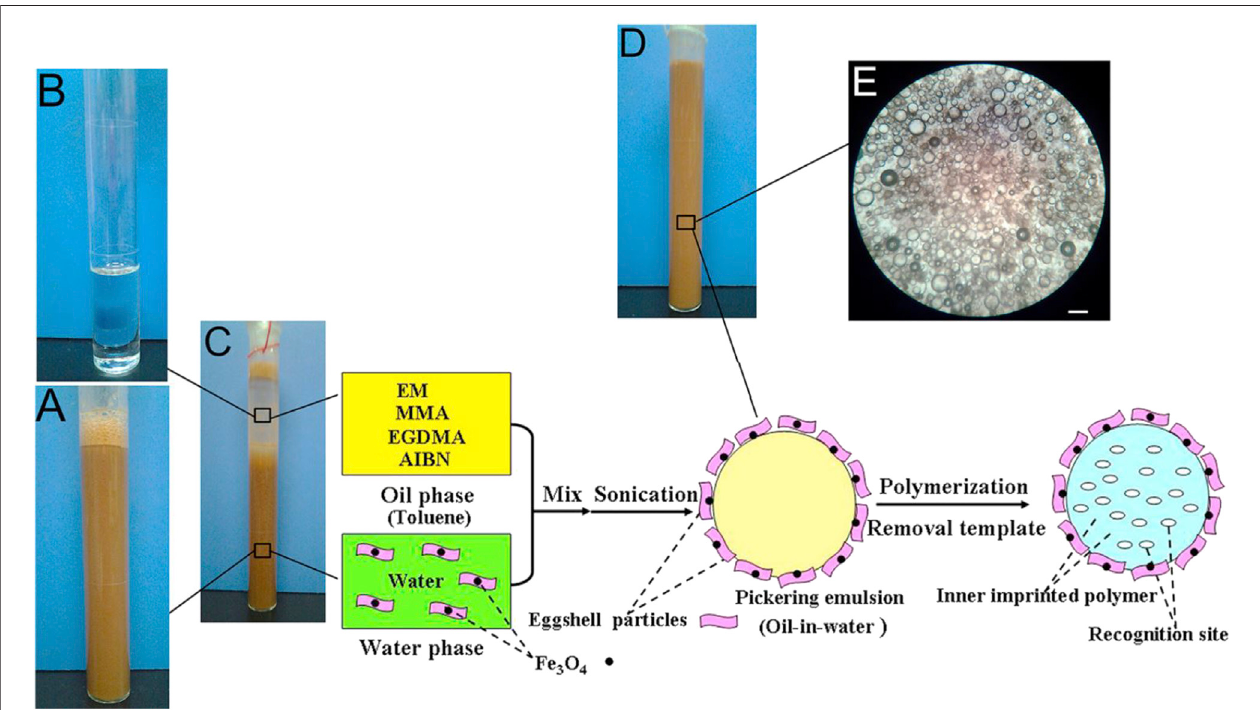
FIGURE 5 | Synthesis approach of MMIPs by Pickering emulsion polymerization: Photographs of a water-phase dispersion (A) , an oil-phase dispersion (B) , and a Pickeringemulsion (C) beforeand (D) afterultrasoni fi cationandthemicrographsofemulsiondropletsstabilizedbyeggshellparticles (E) (scalebars:100 μ m).Reprinted with permission from (Zhu et al., 2016). Copyright (2021)